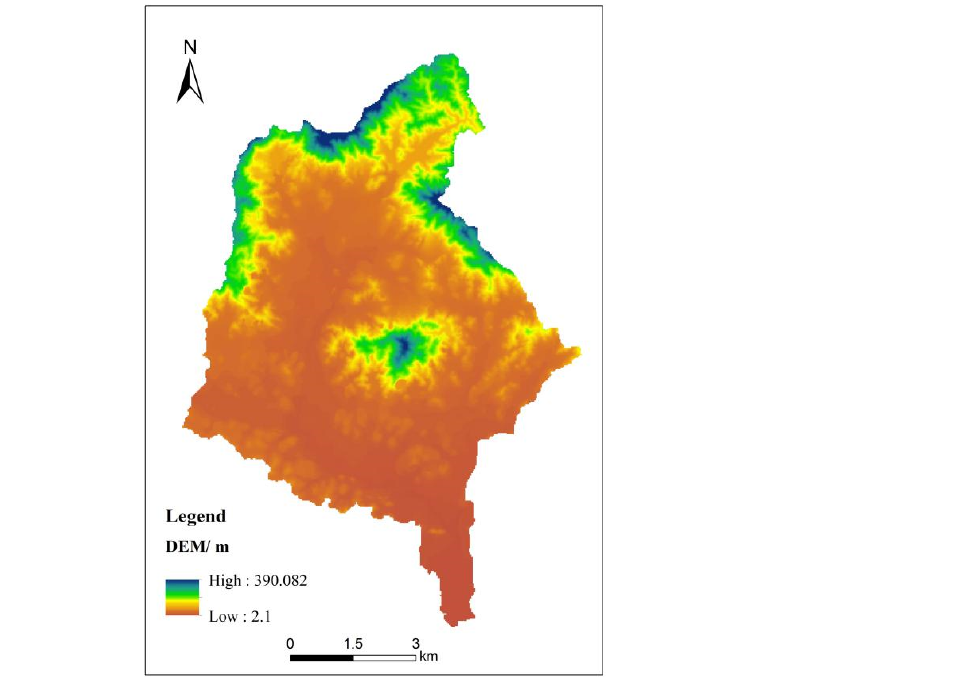
Figure 3. DEM of the Chebei Creek watershed produced using a 1:10,000 vector topographic map of Guangzhou City.